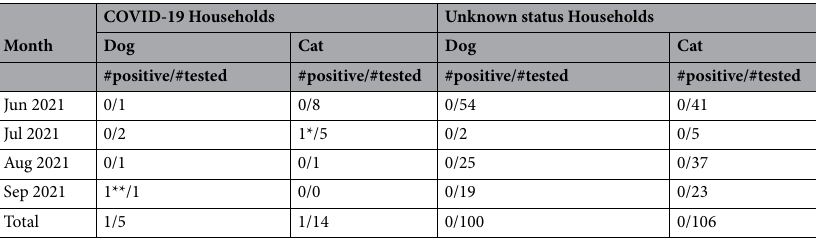
Table 1. SARS-CoV-2 survey in COVID-19 households and unknown status households during COVID-19 outbreak in Thailand from June 2021 to September 2021. *SARS-CoV-2 positive; July 15, 2021. **SARS-CoV-2 positive; September, 12, 2021.